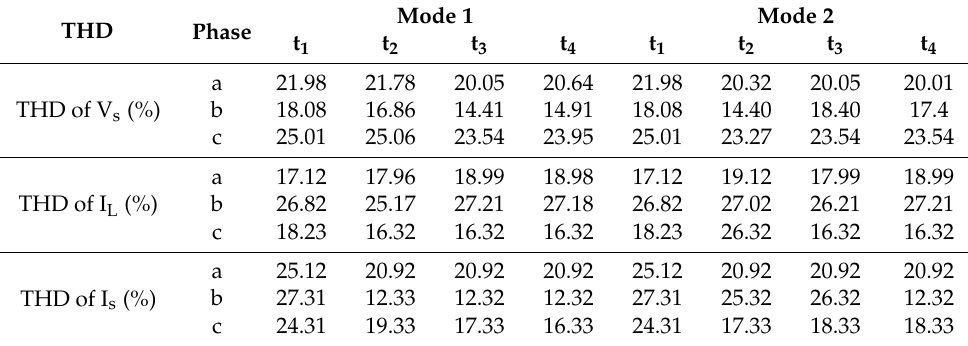
Table 2. Simulation results summary for mode 1 and mode 2